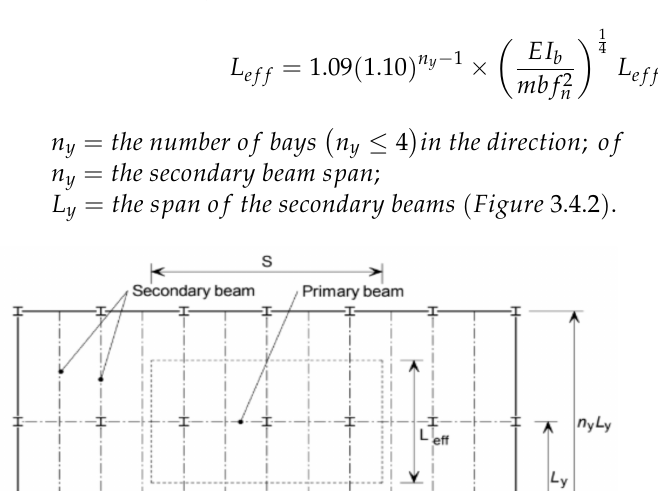
Figure 9. ( a ) Weighting factor diagram; ( b ) Critical damping ratio form [7]. For floor using down stand beams with shallow decking Figure 10: